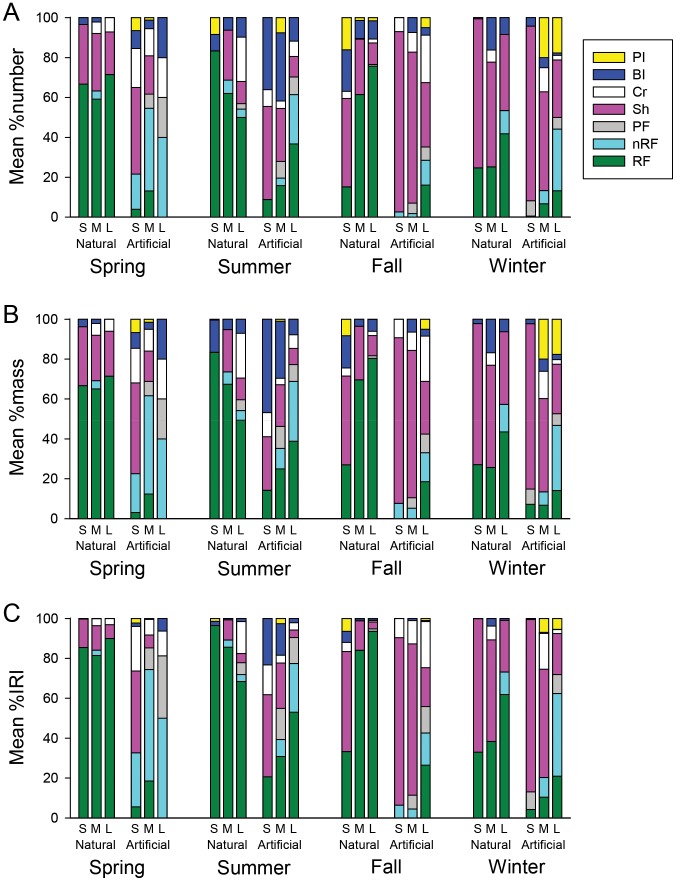
Indices of lionfish diet by habitat, season and size class.Stacked bar plots of A) mean percent diet by number of prey items, B) mean percent diet by prey mass, and C) mean percent index of relative importance for seven prey categories (PI  =  pelagic invertebrates, BI  =  other benthic invertebrates, Cr  =  crabs, Sh  =  shrimps, PF  =  pelagic fishes, nrF  =  non-reef fishes, and RF  =  reef fishes) observed in lionfish stomach samples. Lionfish were sampled with spears in the northern Gulf of Mexico during spring 2013 through winter 14. Size categories: S  =  <200 mm total length (TL), M = 200–250 mm TL, and L = >250 mm TL. Habitat types: natural  =  natural reefs, artificial  =  artificial reefs.